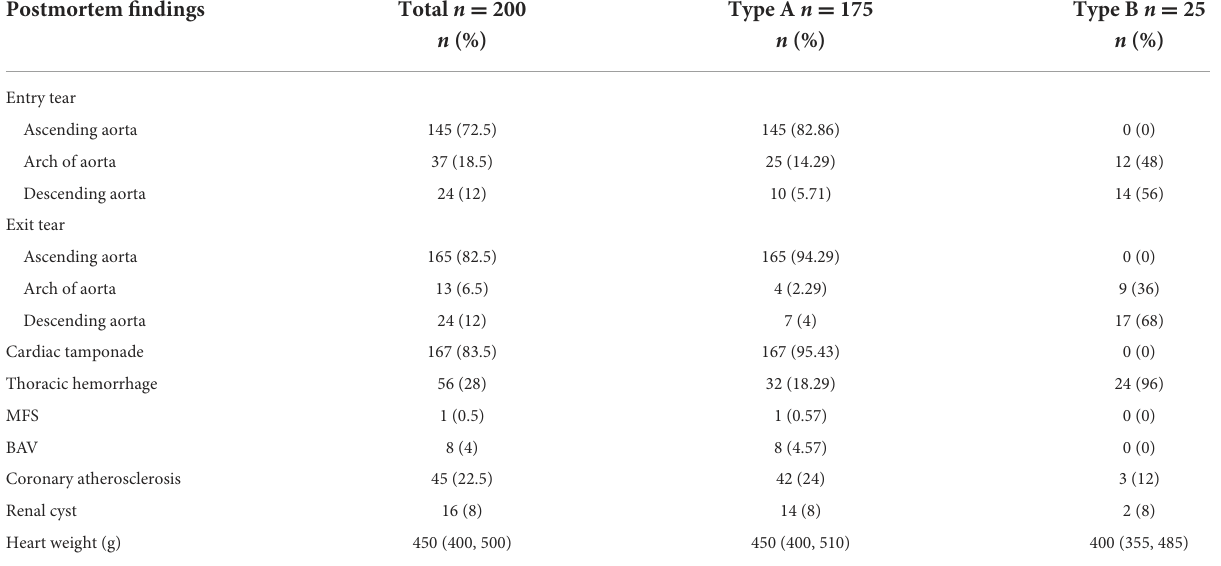
TABLE 3 Postmortem findings in TAD deceased.